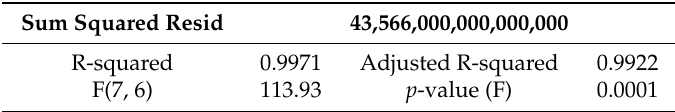
Table 2. Regression analysis data of the relationship between the value of intangible assets and the capitalization of Russian companies.